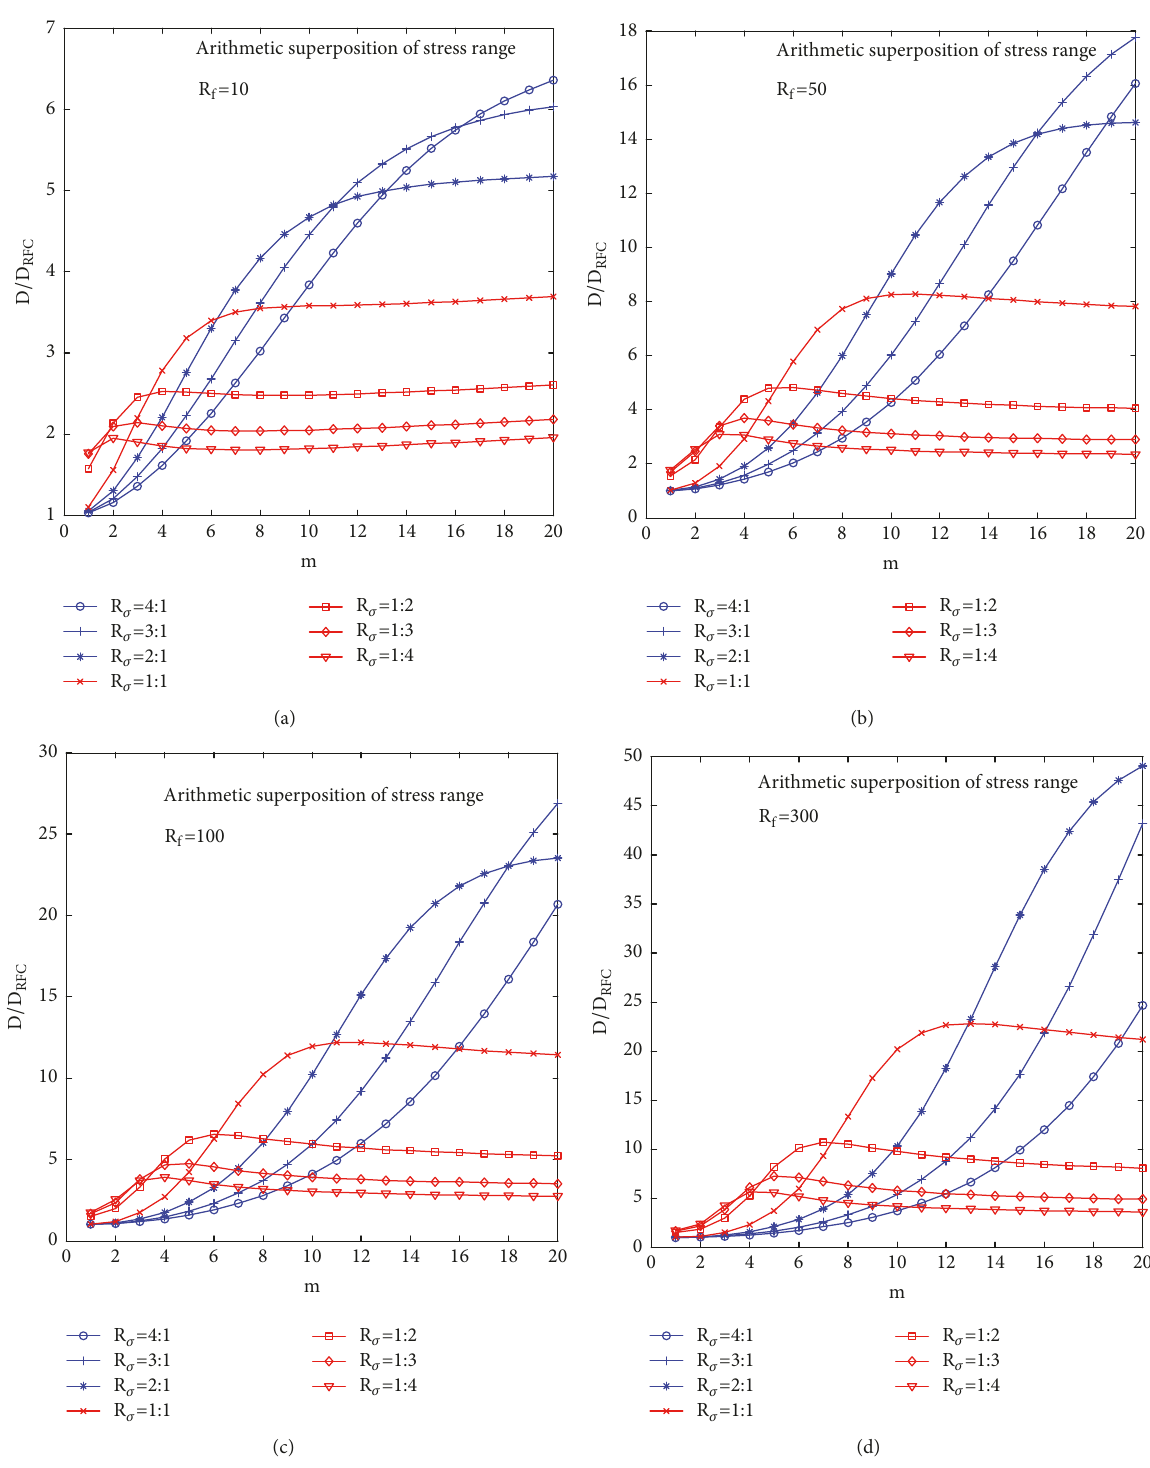
Figure 3: Damage estimation by the arithmetic summation of equivalent stress range in the case of (a) 𝑅 𝑓 = 10 , (b) 𝑅 𝑓 = 50 , (c) 𝑅 𝑓 = 100 , and (d) 𝑅 𝑓 = 300